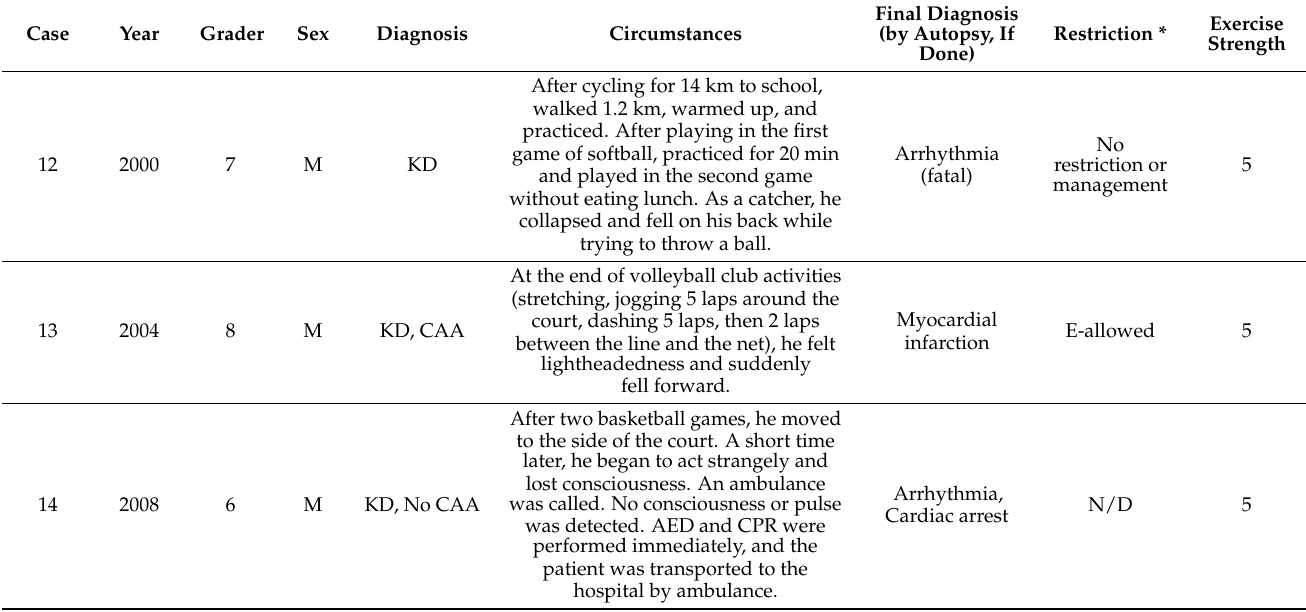
Table 2. Cases of sudden death in students with a history of Kawasaki disease under school supervi- sion (2000–2009).